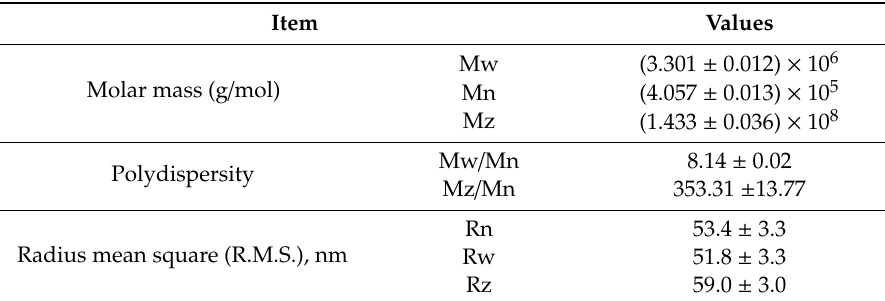
Table 2. The molecular weight, polydispersity, and radius mean square of APS.